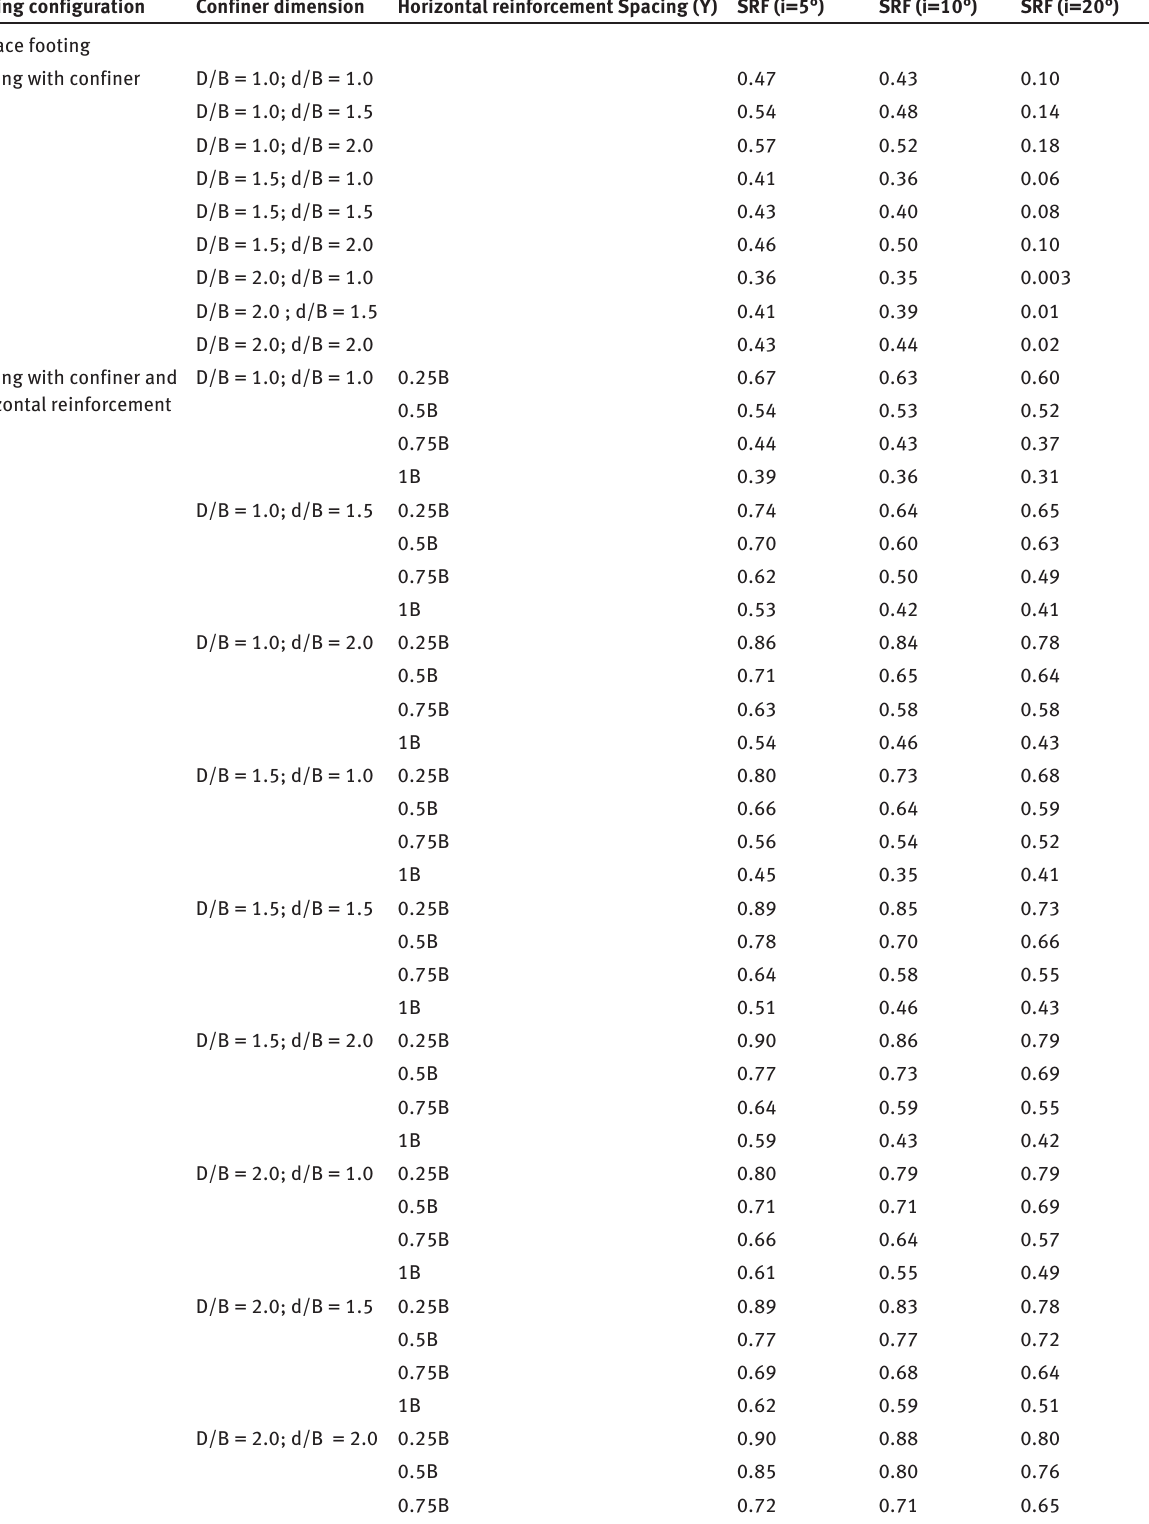
Table 5: Comparison of SRF for different footing configurations under centric inclined loading. Footing